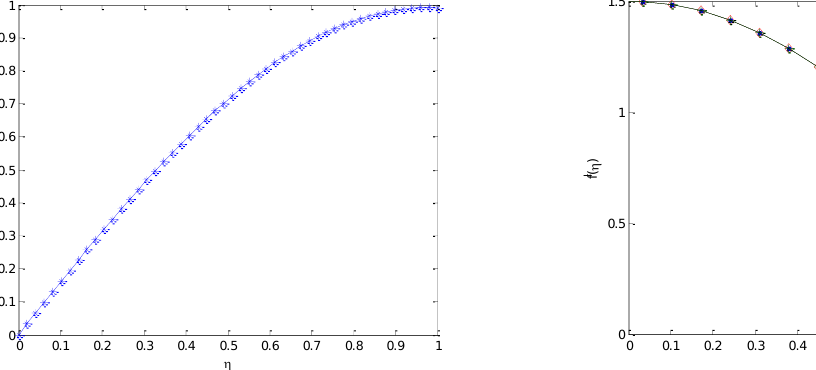
Fig. 2a. Variation of f(η) with the flow length Fig. 2b. Variation of f’(η) with the flow